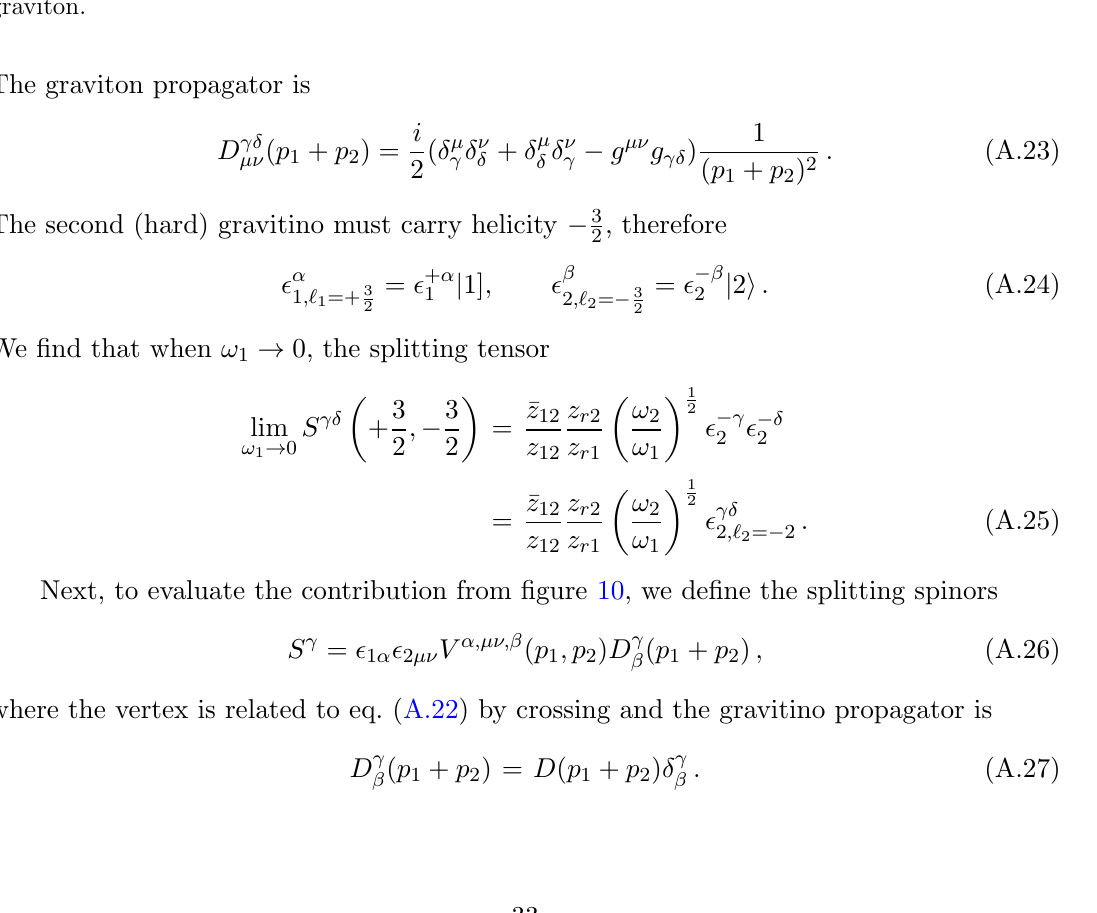
Figure 10 . Feynman diagrams leading to soft gravitino singularities interacting with non-soft